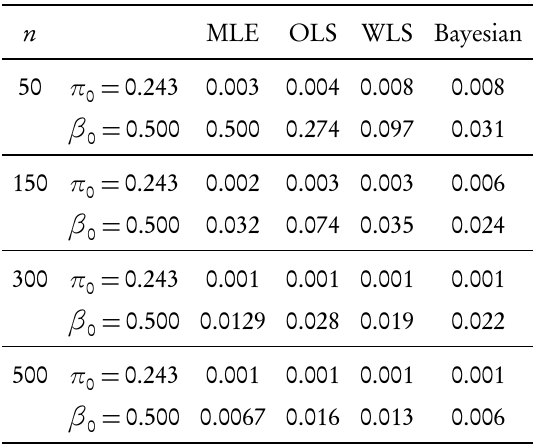
MSEs for combination II .